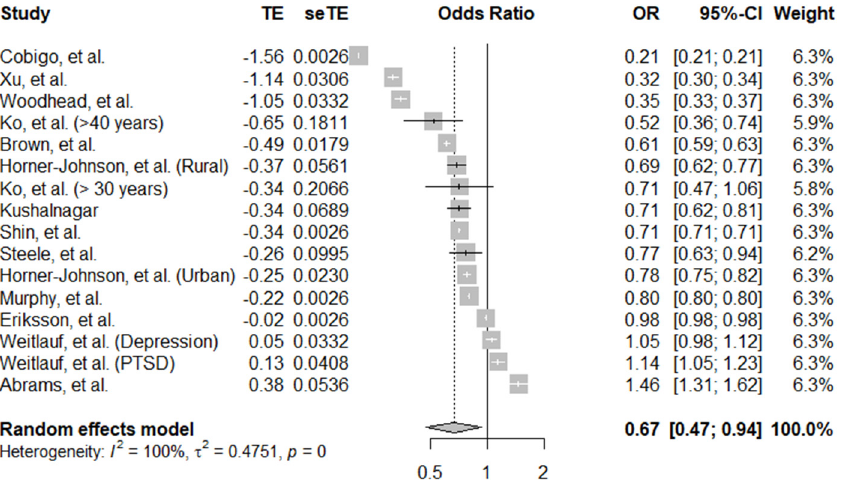
Figure 3. Pooled adjusted odds ratio estimates of cervical cancer screening uptake by disability